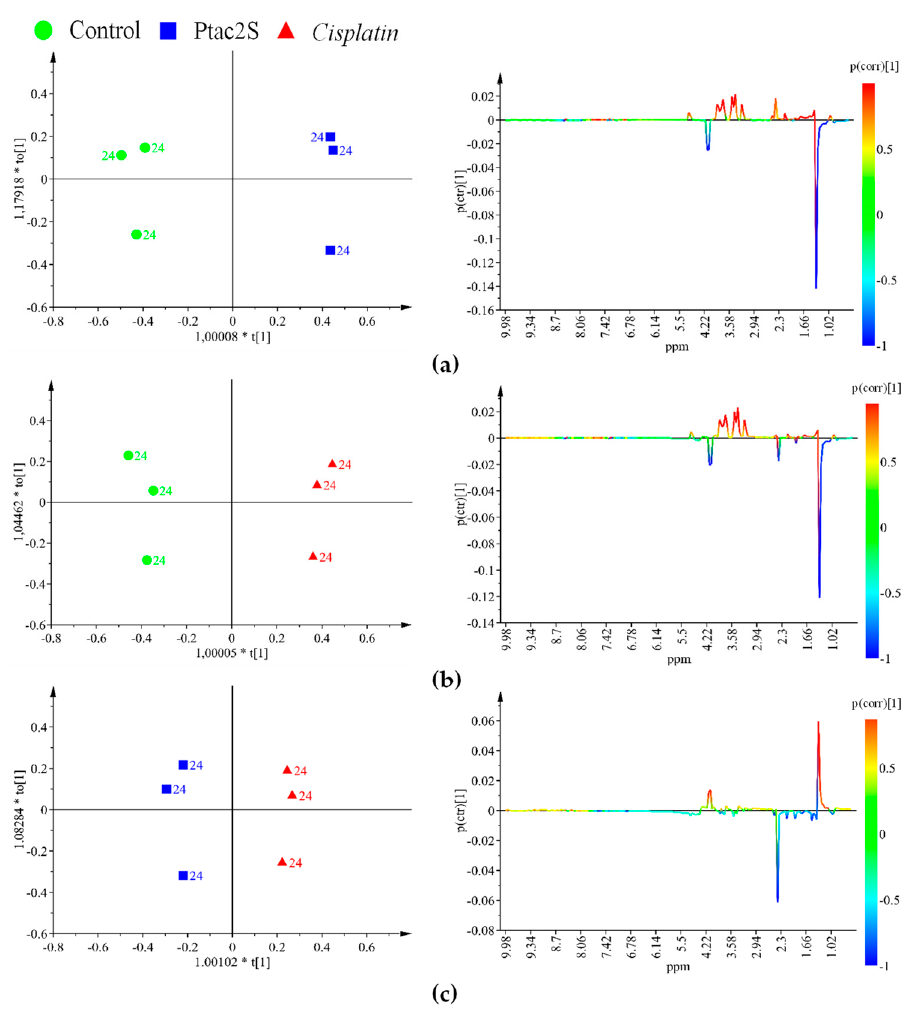
Figure 10. OPLS-DA score scatter plot (left panel) and corresponding coefficient plot (right panel) of the 600 MHz 1 H-CPMG-NMR spectra (Pareto scaled) of SKOV-3 cells culture media obtained from different pairwise groups (controls, Ptac2S, and cisplatin) at 24 h. ( a ) OPLS-DA t[1]/t[2] (two components, 1 predictive + 1 orthogonal, give R 2 X = 0.944, R 2 Y = 0.995, Q 2 = 0.99. ( b ) OPLS-DA t[1]/t[2] (two components, 1 predictive + 1 orthogonal, give R 2 X = 0.913, R 2 Y = 0.989, Q 2 = 0.957). ( c ) OPLS-DA t[1]/t[2] (two components, 1 predictive + 1 orthogonal, give R 2 X = 0.792, R 2 Y = 0.988, Q 2 = 0.871).